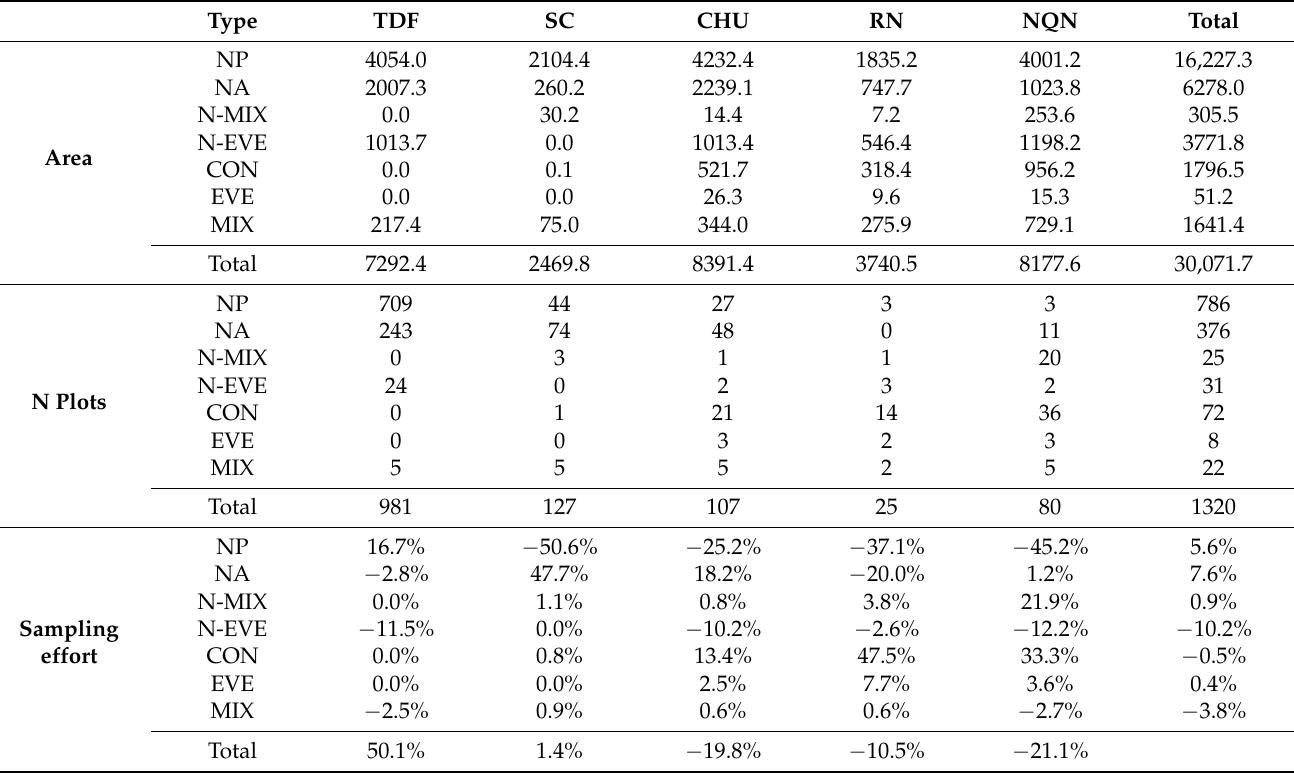
Table 2. Sampling effort for the modeling, showing the area (km 2 ) of the different forest types (see Table 1) and number of plots (stands) in each province (TDF = Tierra del Fuego, SC = Santa Cruz, CHU = Chubut, RN = R í o Negro, NQN = Neuqu é n). Sampling effort compares the percentage of forest area and percentage of plots in each category, where (+) indicates over-sampling relative to extent of forest type, and ( − ) indicates